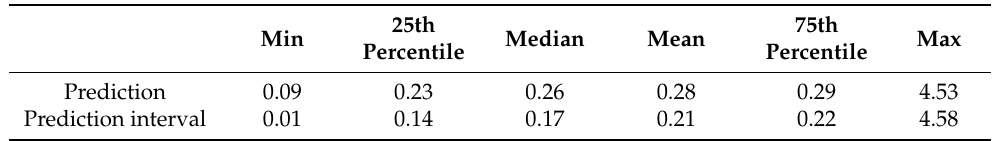
Table 5. Descriptive statistics on the digital soil map (DSM) of cadmium (Cd) concentrations and the 90% prediction interval map (mg kg − 1